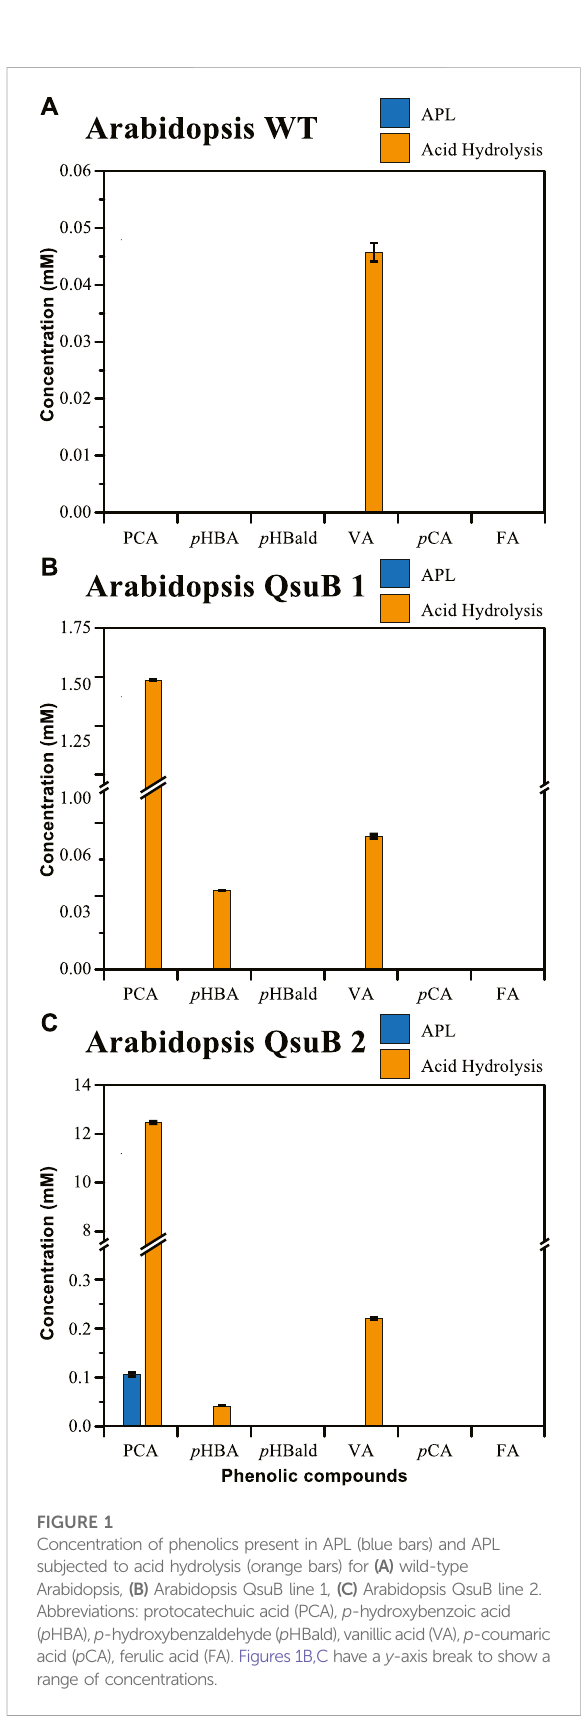
FIGURE 1 Concentration of phenolics present in APL (blue bars) and APL subjected to acid hydrolysis (orange bars) for (A) wild-type Arabidopsis, (B) Arabidopsis QsuB line 1, (C) Arabidopsis QsuB line